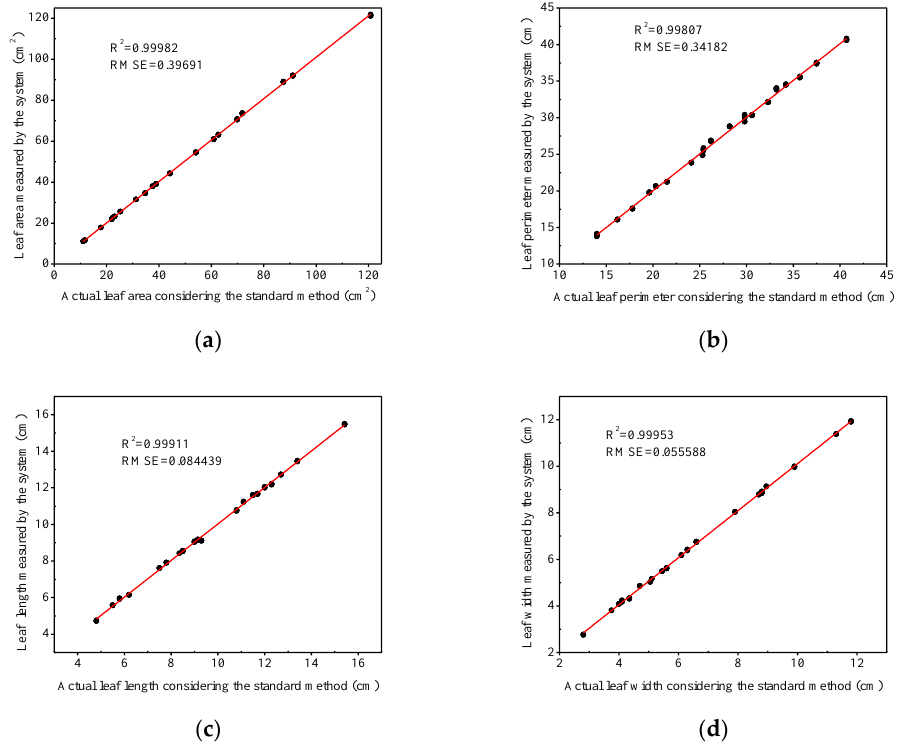
Figure 11. The relationship between leaf geometric parameters measured by the traditional method and by the developed system. ( a ) Leaf areas; ( b ) leaf perimeters; ( c ) leaf lengths; and ( d ) leaf widths. The relative error range of the different leaf area measured by the developed system and that of by the grid method were also compared (Figure 12). The influence of leaf size on the relative error of measured leaf area was not significant. The relative error of the measured area for all leaves ranged from −1.37% to 2.52%. Most of area values measured by the developed system were larger than the actual values of the leaf areas, especially when the leaf area was larger than 60 cm 2 . The relative error of the measured area reached the maximum value at the 72 cm 2 , while the other relative errors were less than 2 % . These results indicated that the performance of the developed system may influenced by the environment.